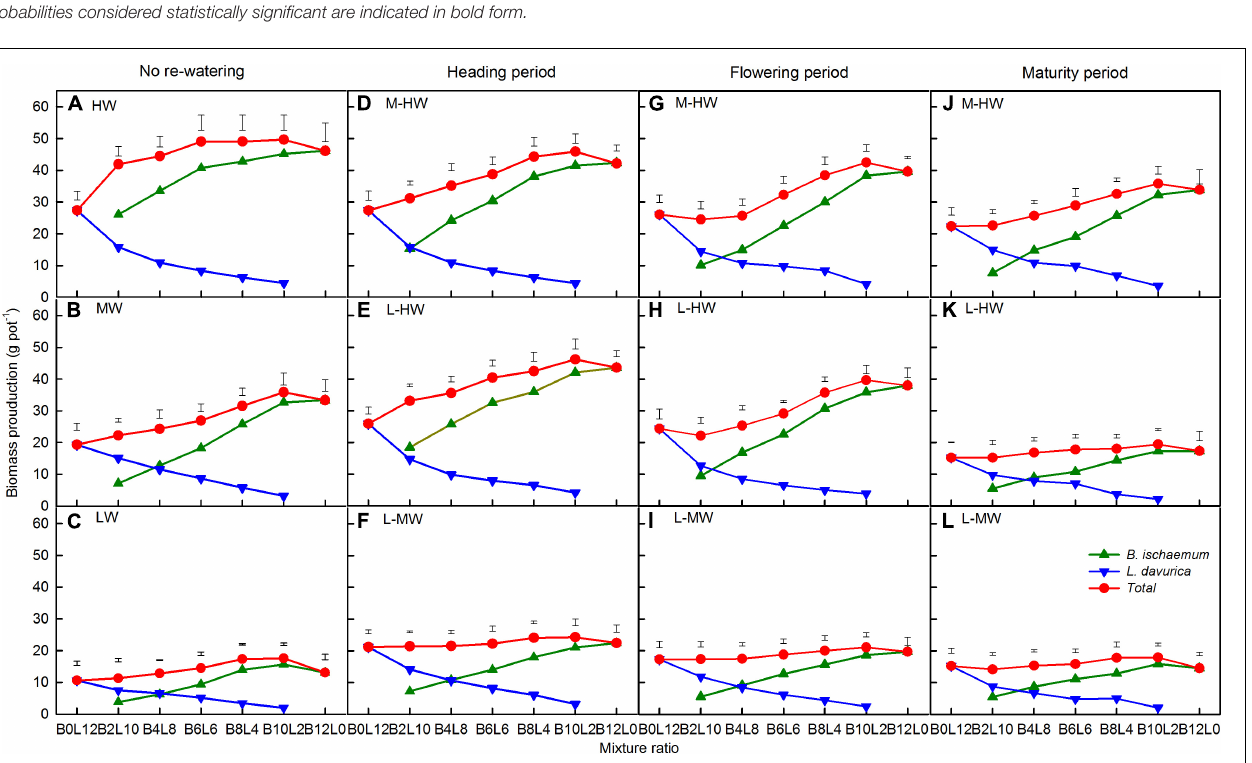
FIGURE 2 | (A–L) The total biomass production of B. ischaemum (B) and Lespedeza davurica (L) under the soil watering treatments during different growth periods within the replacement series. B i L j ( i, j = 0, 2, 4, 6, 8, 10, 12; i + j = 12) in abscissa indicates the plant numbers of B. ischaemum to L. davurica in the mixtures; Vertical bars represent least significant difference (LSD) 0.05 values. Refer to Figure 1 for the codes of the water